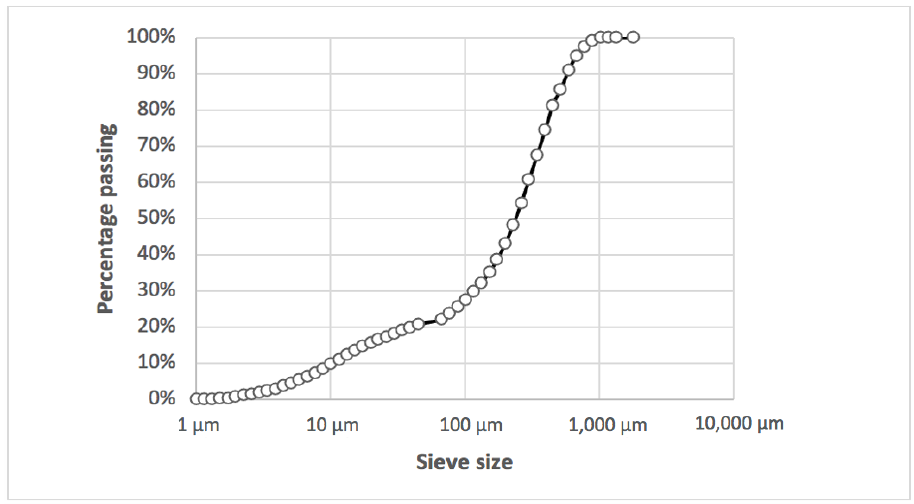
Figure 2. Average particle size distribution of BHP tailings, in duplicate (n = 2).